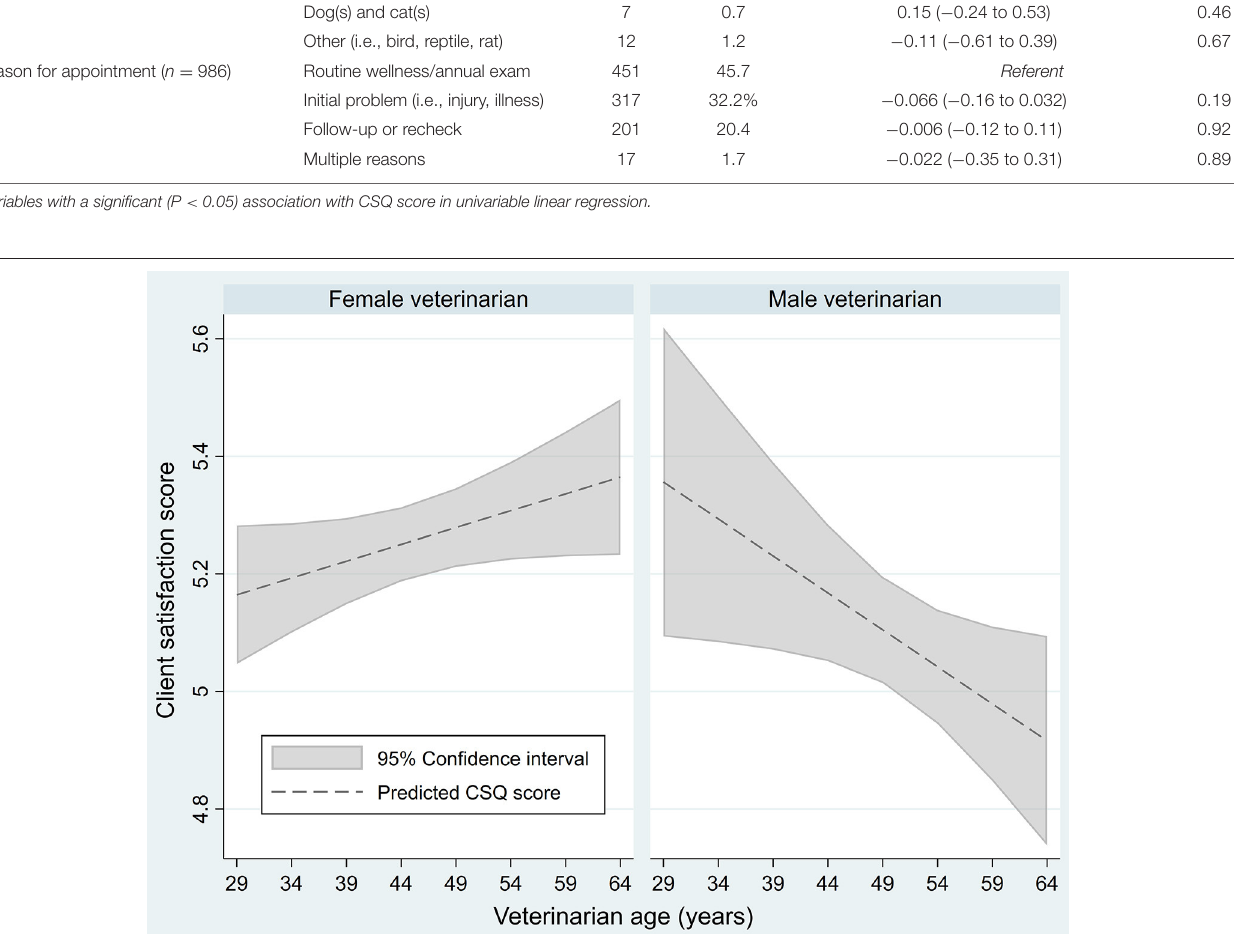
presented here includes the data from all 60 veterinarians and 823